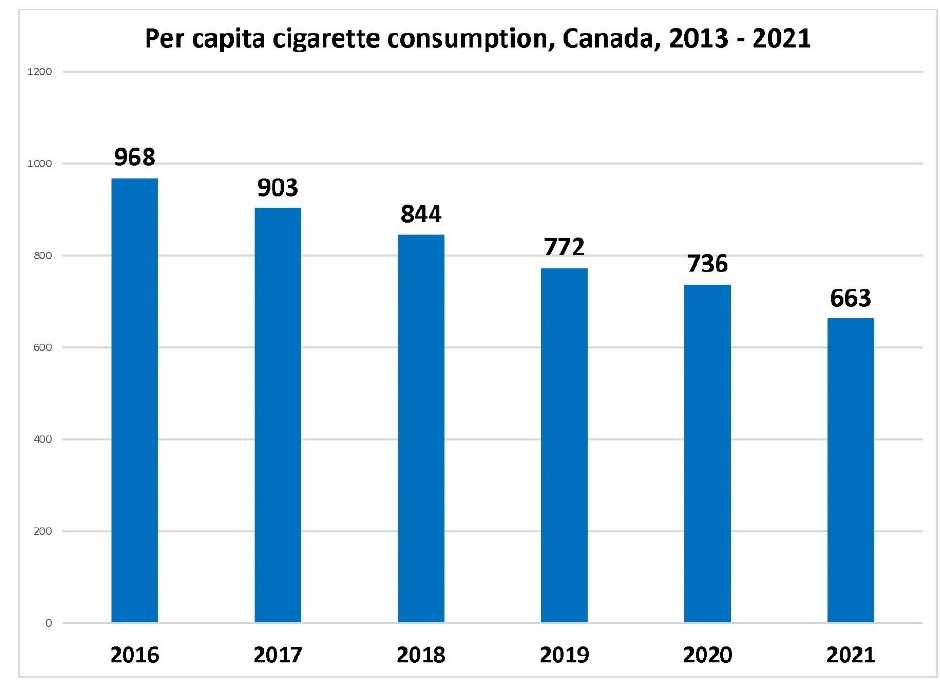
Figure 1. Per capita cigarette consumption, Canada, 2016–2021 (first 9 months). Sources: Annual cigarette and roll-your-own tobacco sales, 2016–2020 inclusive, from Health Canada, based on tobacco industry reports pursuant to Tobacco Reporting Regulation; sales volumes for 2021 based on a 9.3% decline for the Canadian market as reported by Philip Morris International; Canadian population data from Statistics